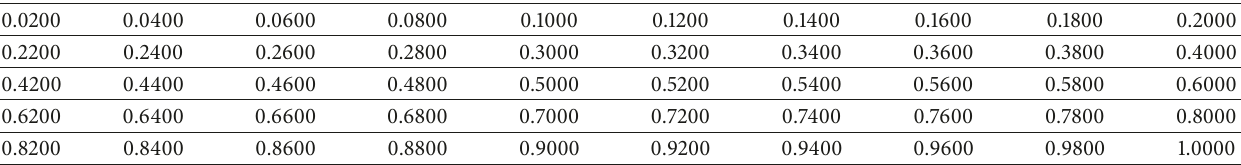
Table 4: Value of parameter 𝛾 .